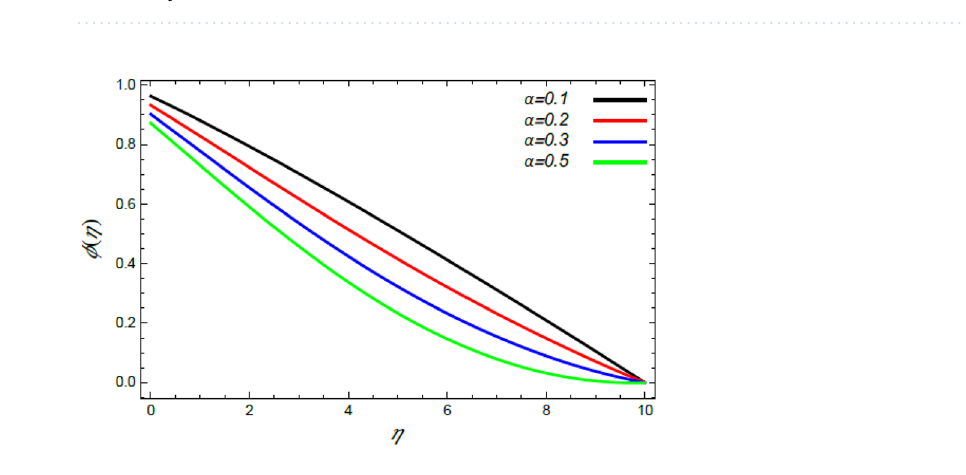
Figure 19. Deviation of the heat profile θ(η) versus η as given in Eq. (66) to illustrate the impact of the Schmidt numeral S c .